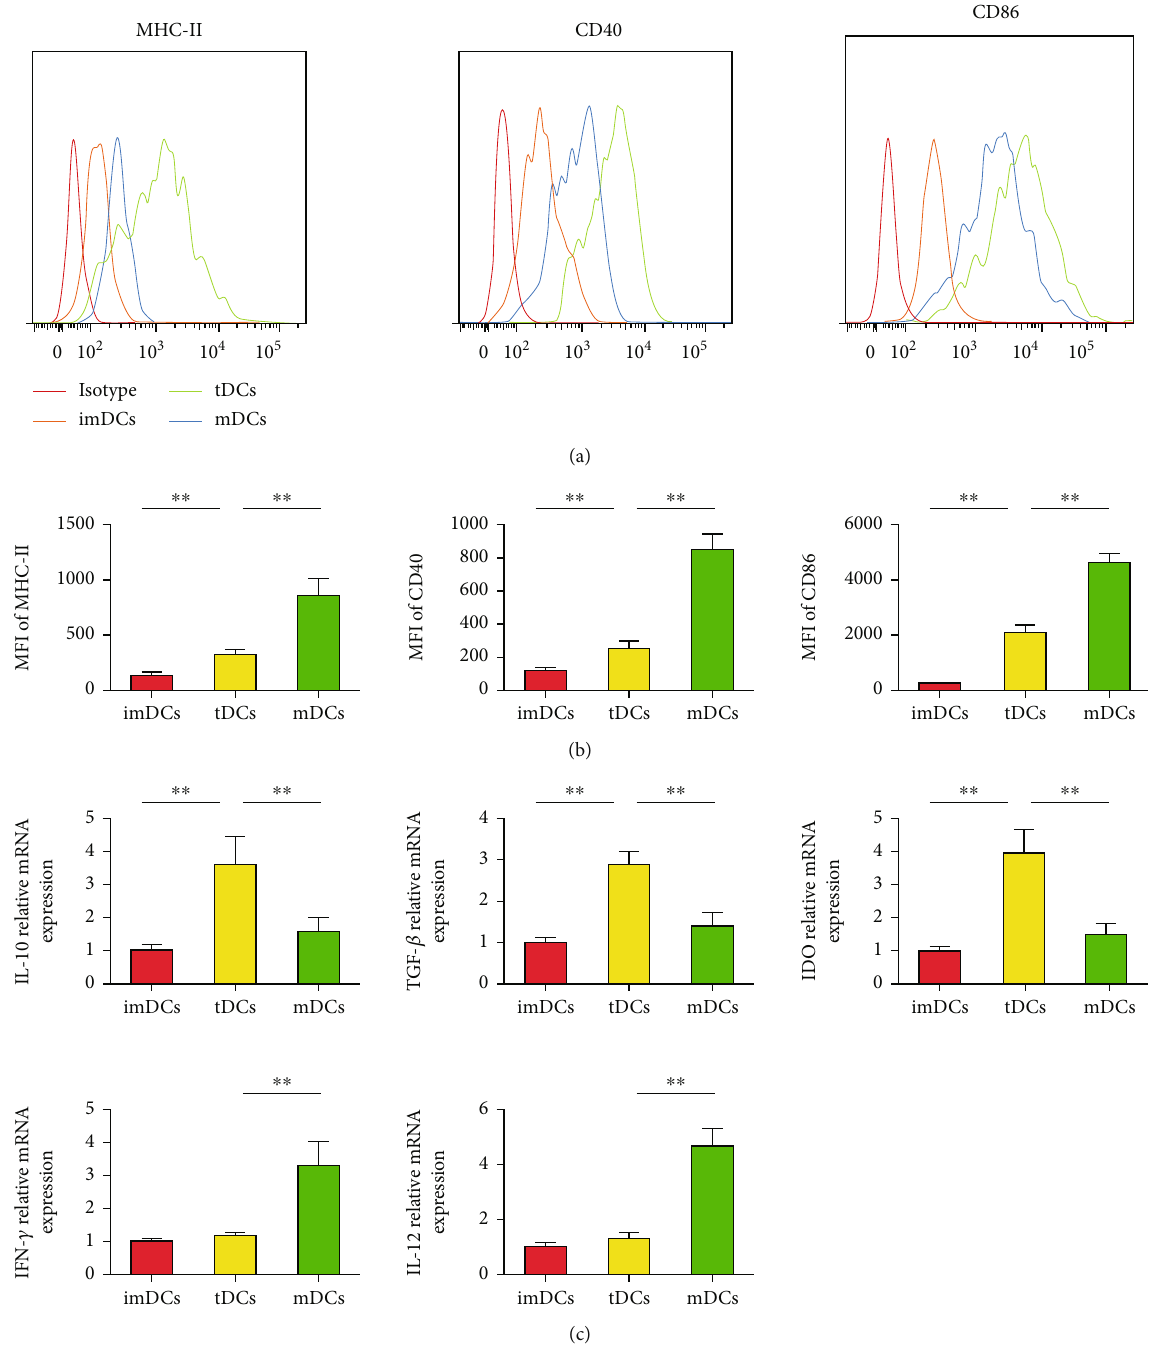
Figure 9: Tolerogenic dendritic cells (tDCs) increase the percentage of regulatory T cells (Tregs) in vitro. (a), Splenic CD4 + T cells ( 1 × 10 6 cells/mL) were cultured for 3 days in the presence of medium alone or combined with immature DCs (imDCs), mature DCs (mDCs), or IL- 27-tDCs ( 2 × 10 5 cells/mL). The cells were labeled 72 hours later with anti-CD4, anti-CD25, and anti-Foxp3 and analyzed by FACS. FACS data are representative of 1 of 6 to 8 independent experiments (each coculture preparation was prepared from a di ff erent mouse). (b) Graphs represent the average percentages of Tregs in CD4 + splenic T cells of di ff erent groups. (c) Analysis of the mRNA levels of interferon- γ (IFN- γ ), IL-17A, Foxp3, interleukin (IL) – 10, and transforming growth factor- β (TGF- β ) in di ff erent groups. No DCs group n = 6 , imDCs group n = 8 , mDCs group n = 8 , and tDCs group n = 8 . ∗∗ P < 0 : 01